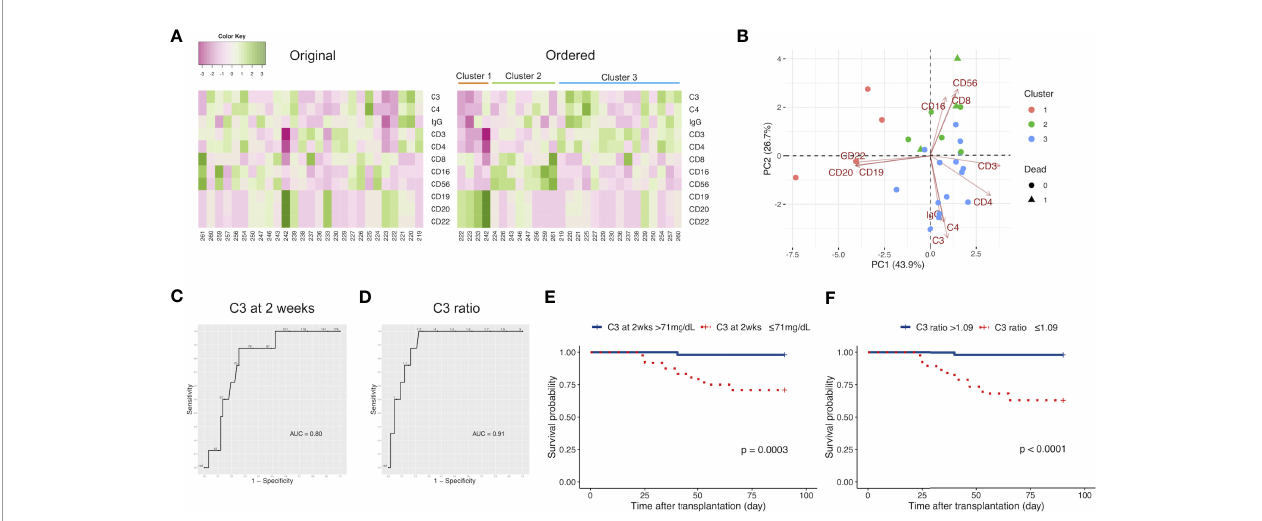
FIGURE 2 | (A) Heat maps of the C3, C4, and IgG levels, and the leukocyte populations at 2 weeks after LDLT with the original order (left panel) and the k-means clustering order (right panel). The numbers below the heat maps show the case number of each patient. (B) The two-dimensional principal component analysis using C3, C4, and IgG, and the leukocyte populations at 2 weeks after LDLT. The colors indicate the cluster made by k-means clustering. Circles: survivors. Triangles: non-survivors. (C) The ROC curve for the serum levels of C3 at 2 weeks after LDLT to distinguish non-survivors from survivors at day 90. (D) The ROC curve for the ratio of C3 at 2 weeks after LDLT to C3 at 1 week after LDLT (C3 ratio) to distinguish non-survivors from survivors at day 90. (E) The Kaplan-Meier estimates for 90- day survival of patients with a C3 level at 2 weeks of ≤ 71 mg/dL and patients with a C3 level at 2 weeks of > 71 mg/dL. (F) The Kaplan-Meier estimates for 90-day survival of patients with a C3 ratio of >1.09 and patients with a C3 ratio of ≤